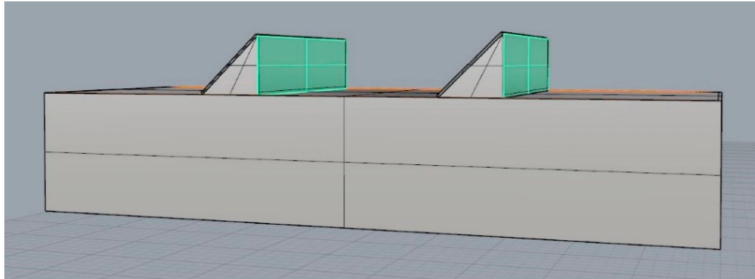
Figure 5. Saw tooth roof typical arrangement.